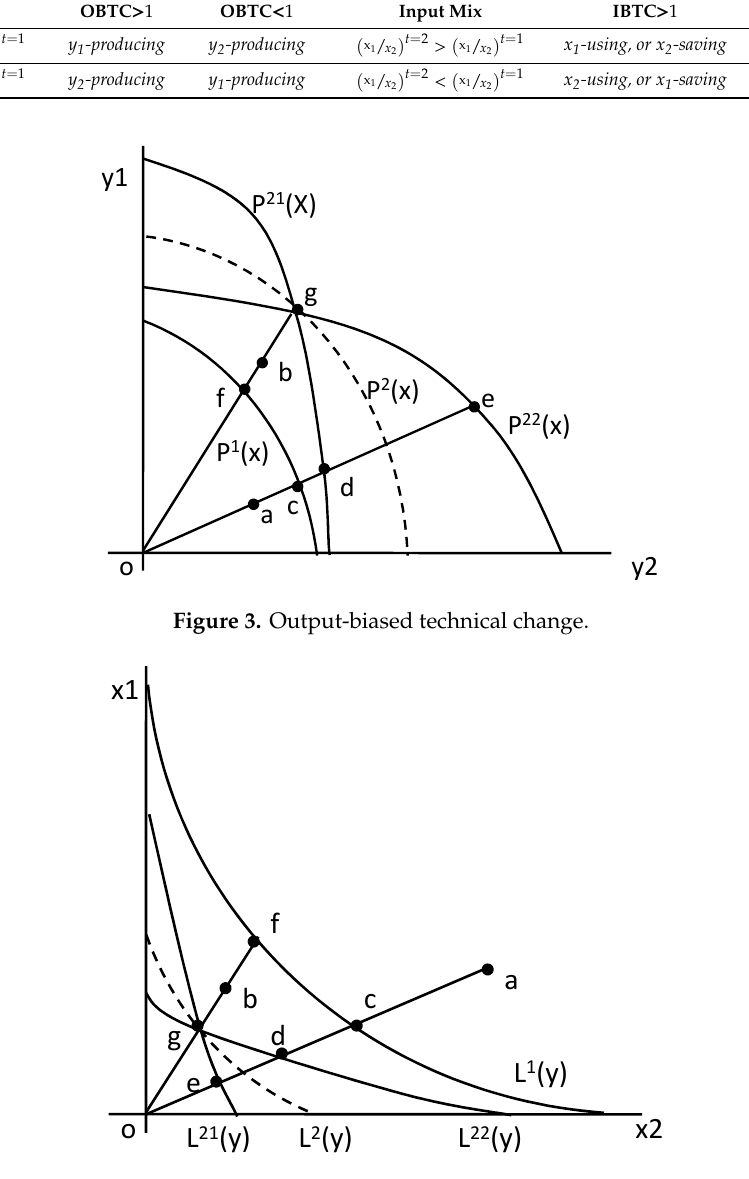
Figure 4. Input-biased technical change.